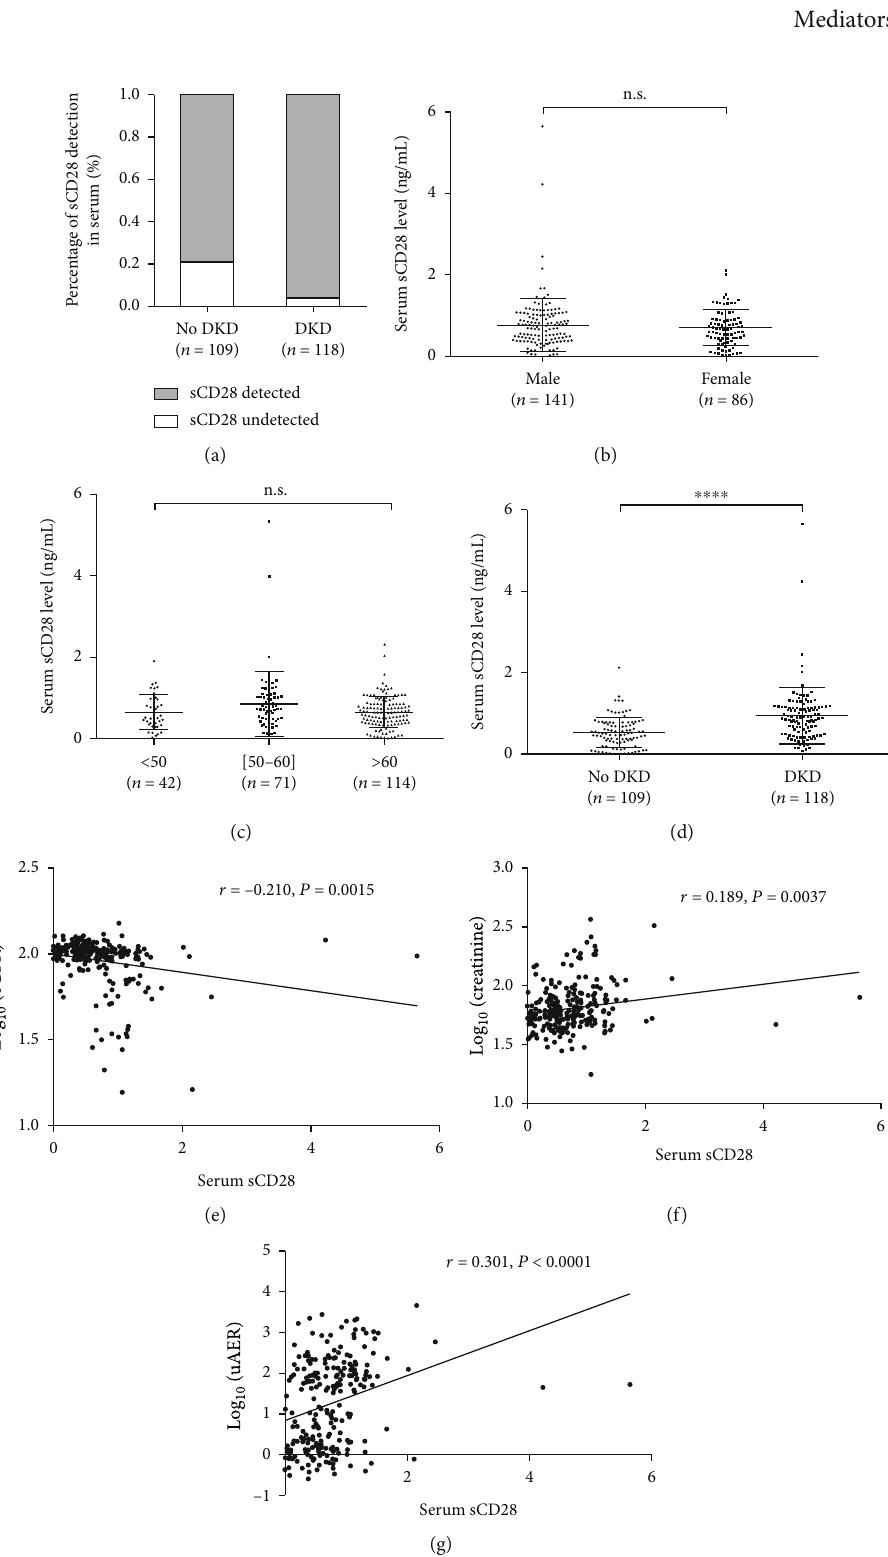
Figure 2: Serum sCD28 levels in patients with T2DM and its association with DKD and related traits. (a) Owing to limited assay sensitivity, sCD28 was not detectedin several patients(21% in the controlgroup and4% in the DKD group). (b) Comparison of serum sCD28 levels in male and female patients in the study population ( P > 0 : 05 ). (c) Comparison of serum sCD28 levels in di ff erent age groups ( P > 0 : 05 ). (d) Comparison of serum sCD28 levels in DKD and control groups. (e) Relationship between serum sCD28 levels and log-transformed eGFR ( r = − 0 : 210 , P = 0 : 0015 ). (f) Relationship between serum sCD28 levels and log-transformed creatinine ( r = 0 : 189 , P = 0 : 0037 ). (g) Relationship between serum sCD28 levels and log-transformed urinary albuminuria excretion rate ( r = 0 : 301 , P < 0 : 0001 ). n.s. means not signi fi cant ( P > 0 : 05 ); ∗∗∗∗ P < 0 : 0001